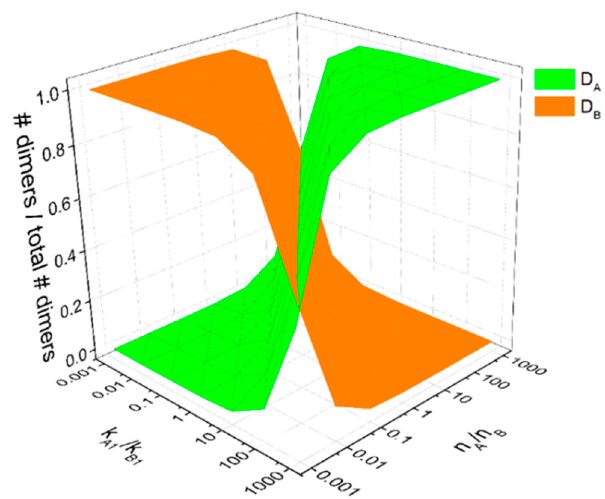
Figure 6. Two-ligand, one-receptor model parameter space. The fraction of dimers formed bound with ligand L A versus bound to ligand L B shifts as a function of the relative ligand: receptor binding kinetics k A1 /k A2 and the relative ligand concentrations [L A ]/[L B ].